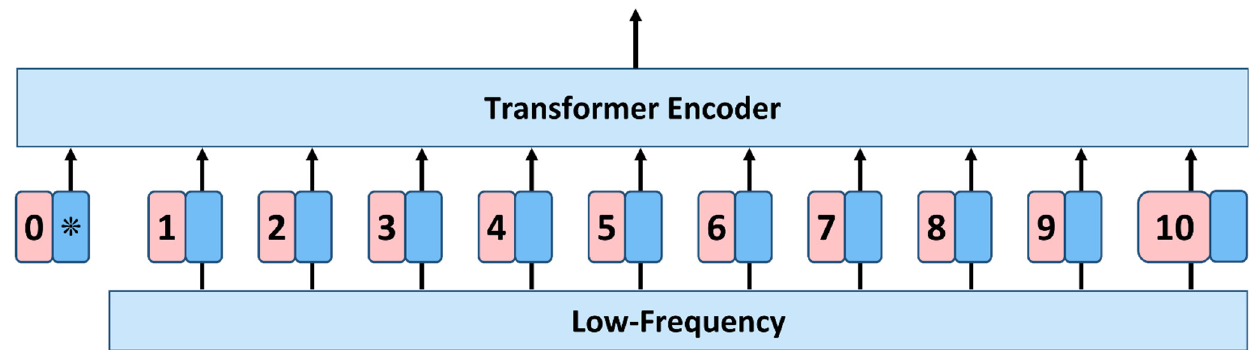
Figure 4. Structure of Attention Block. We add a positional embedding to the low-frequency